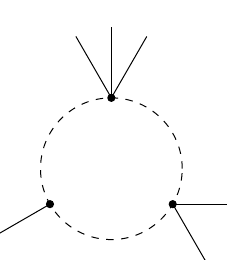
Figure 1 . Generic one-loop graph. The internal (dashed) lines are fluctuation fields, η I and ζ A and the external (solid) lines are the background fields Φ I and A Bµ B . All interaction vertices are quadratic in the